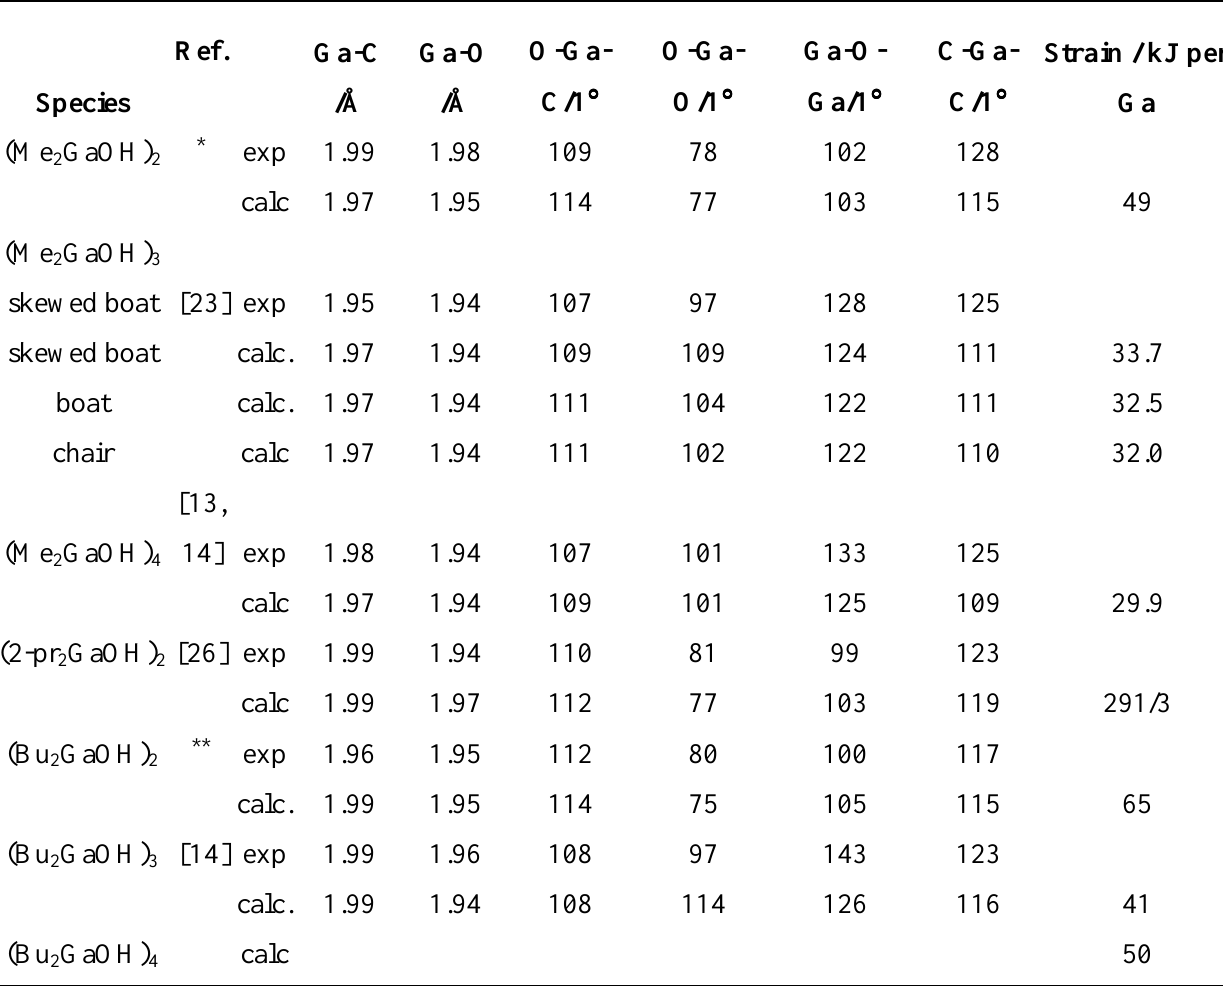
Table 3 . Comparisons between results from force field calculations and experimental data. In case more than one observable is measured only an average value is